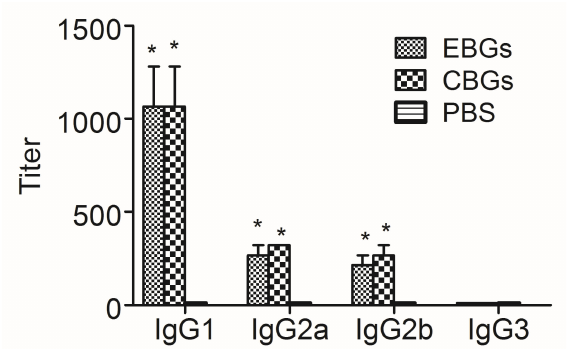
Figure 4. Antibody subtype profiles of mice immunized with various vaccines. Mice were inoculated intragastrically with BGs. Mice that received a PBS injection were negative controls. Two weeks after the last immunization, both the sera and irrigating solution were collected from the experimental mice, and antibody titers were evaluated by an ELISA. Data are from two independent experiments. Each bar represents the mean titers of antibodies in the same group. * p < 0.01, as compared with the PBS group.